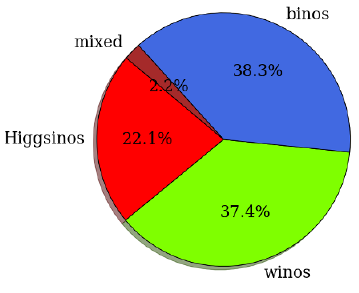
Figure 4 . Fractions of neutralino 1 types in our scan after imposing only the light Higgs mass